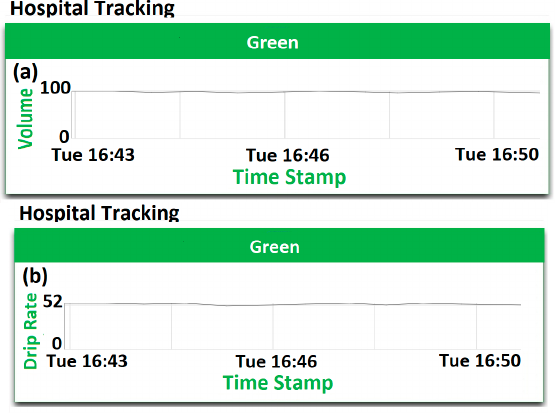
Figure 20. Dashboard report of: ( a ) volume left in chamber and ( b ) drip rate.